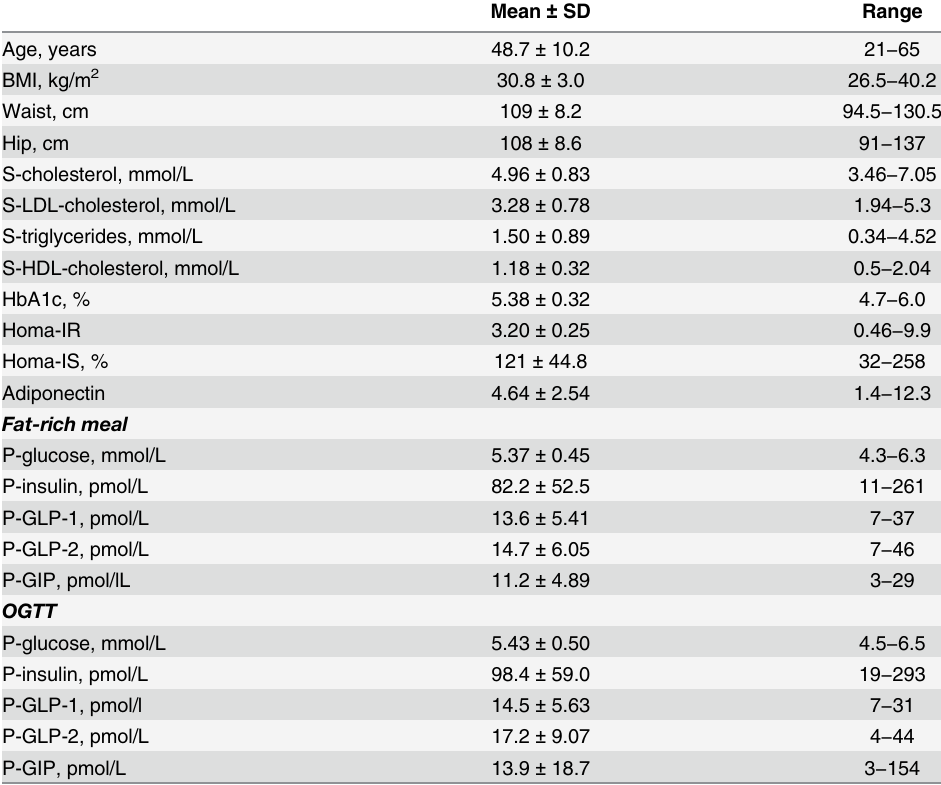
Table 1. Baseline characteristics. Subject characteristics and fasting concentrations of glucose, insulin, GLP-1, GLP-2 and GIP before fat-rich meal and OGTT. Data are mean ± standard